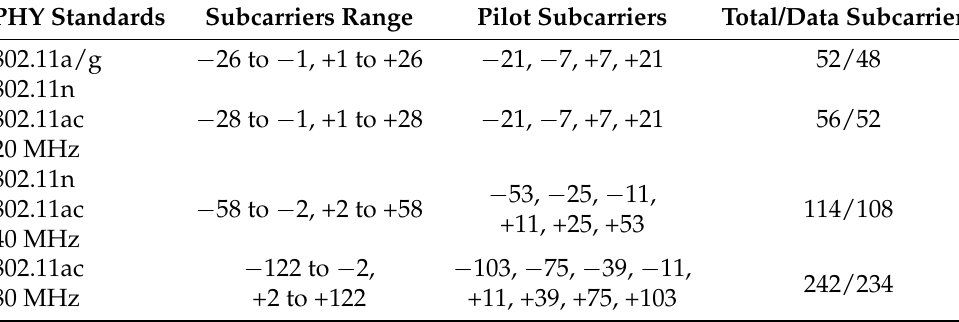
Table 1. Subcarrier description for each PHY